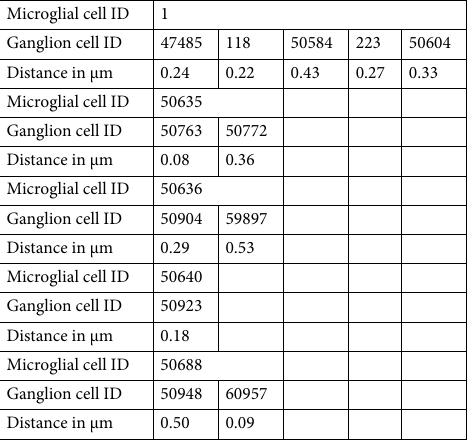
Table 2. Synapse distances from sites of trogocytosis. The geometric distances between sites of trogocytosis by microglial cells and the sites of the nearest synapses were calculated. OFF midget ganglion cells were selected for this analysis because their distal dendrites receive frequent synaptic inputs. This data provides support for our observation that sites of trogocytosis were sometimes close to sites of synapses but did not include the synapses, themselves.